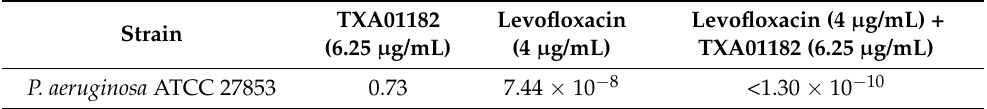
Table 5. Frequency of resistance to TXA01182 and levofloxacin, alone and